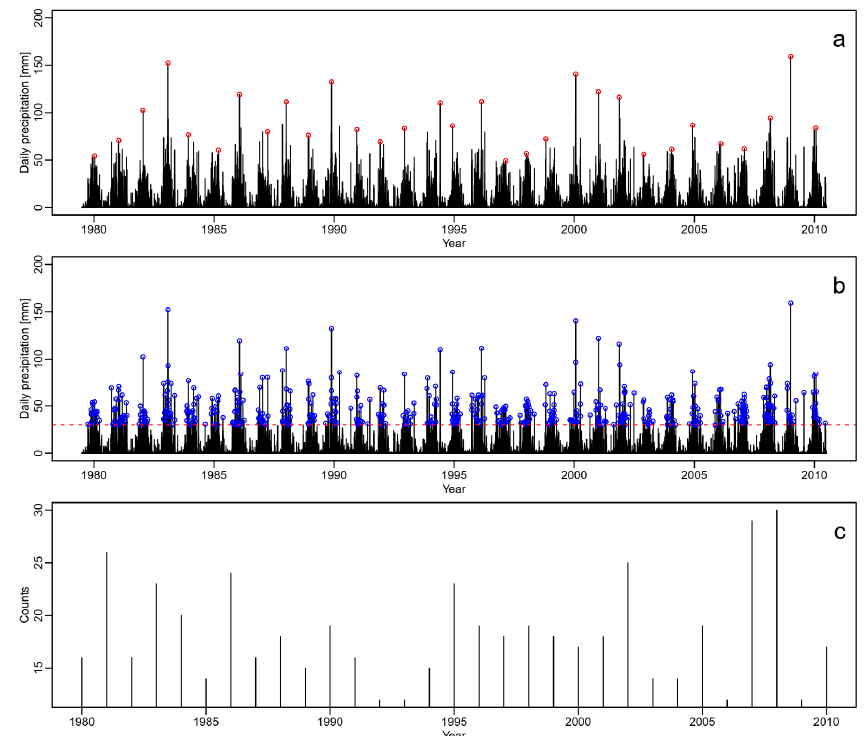
Figure 2. An example of deriving the annual maxima precipitation (PMAX) and heavy precipitation days (N95) time series from daily precipitation. ( a ) Daily time series (black histogram) and the PMAX events (red dots). ( b ) Daily time series (black histogram) and the peak-over-threshold events (blue dots); the horizontal dashed line represents the threshold (the 95th percentile of the empirical distribution). ( c ) The values of the N95 variable (i.e., the number of heavy precipitation days per year; heavy precipitation events were identified in Figure 2b).